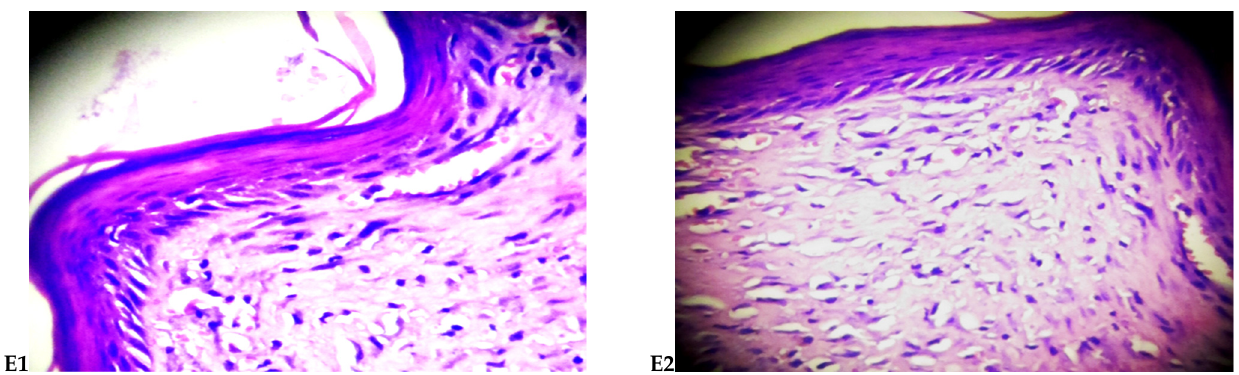
E1 E2 ( E ) Seventeen-day-old wound tissue treated with the EOLS topical cream formulation: E1 (X10), E2 (X40); E: epidermal layer, Ep: epithelium. Gs: sebaceous gland. K: kratin. PNN: neutrophil polynuclear cells. Vs: blood vessels. Figure 6. Photomicrographs of sections of skin from rats stained with H&E. Skin microscopic image of ( A ) normal rat, ( B ) wound control rat, ( C ) positive control rat, and ( D , E ) EOLS topical cream formulation-treated rat. Table 4. Wound healing processes and healing phases of the vehicle, EOLS cream, and Madecassol ® administered to